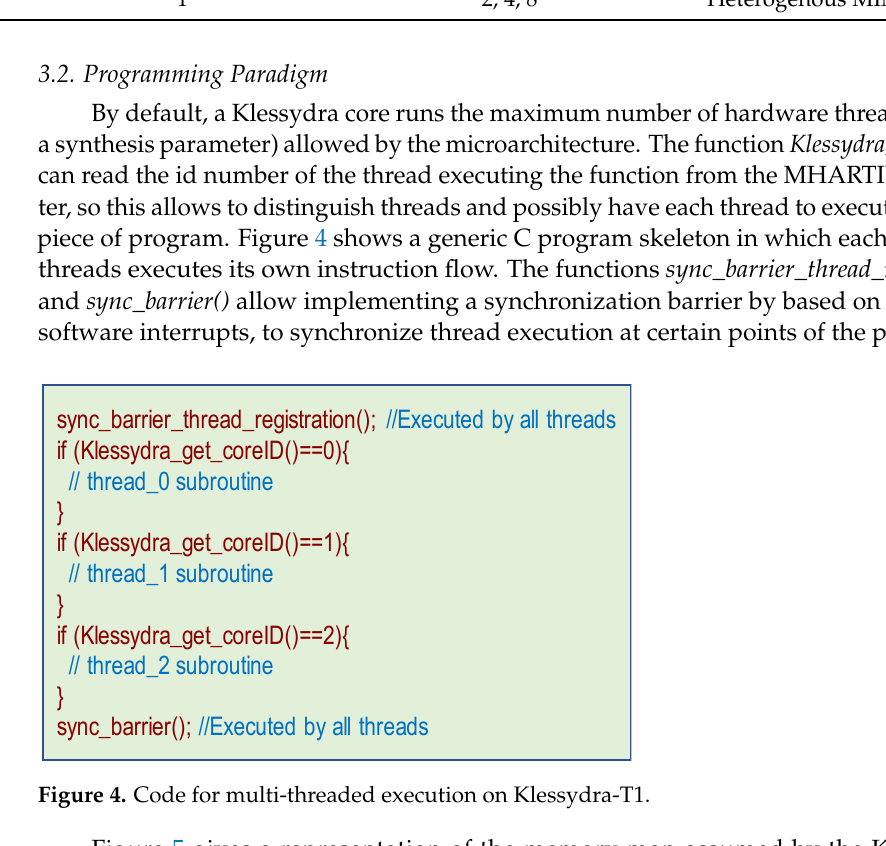
Figure 5. Klessydra T1 memory map. The SPM local storage is visible to the programmer as a specific address region in the memory map. The programmer can move data to/from any point of the SPM address